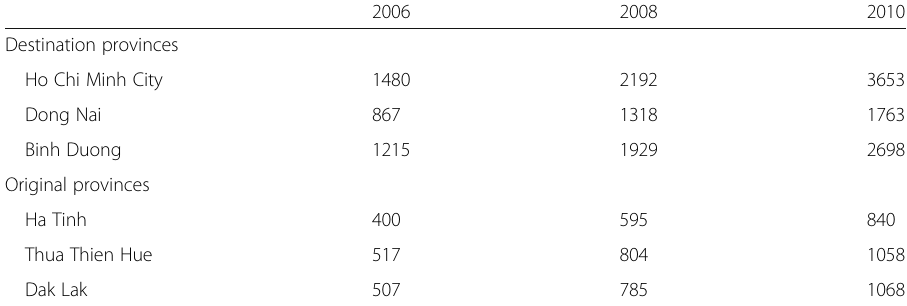
Table 8 Income per capita of selected destination and original provinces (thousand VND per